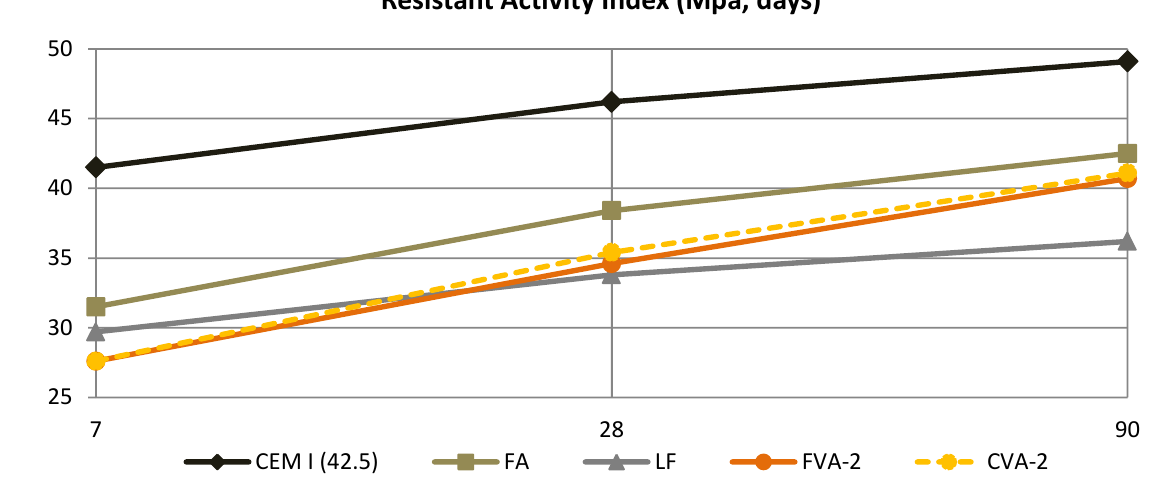
Figure 10. Progress in resistance activity index.